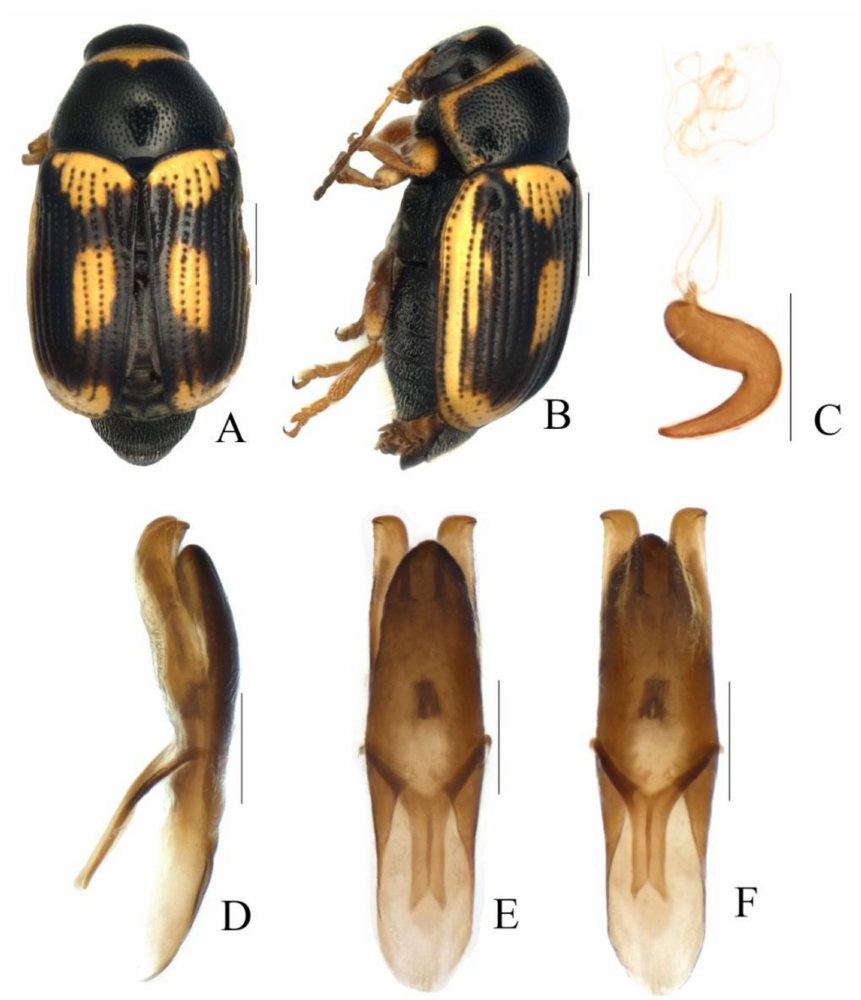
Figure 38. Cryptocephalus ( Burlinius ) yangweii Chen, 1942: ( A ) habitus; ( B ) lateral view of habitus; ( C ) spermatheca; ( D ) lateral view of aedeagus; ( E ) dorsal view of aedeagus; ( F ) ventral view of aedeagus (Scale bars: ( A , B ) = 0.5 mm, ( C – F ) = 0.2 mm) (( A , B , D – F ): paratype, male; ( C ): paratype, female; both from